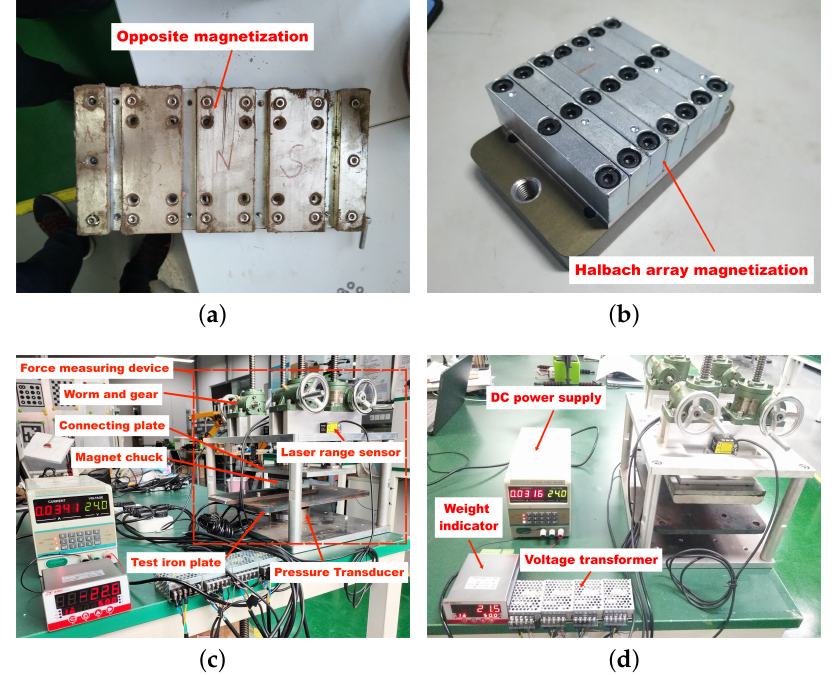
Figure 19. Practical test of the permanent magnetic chuck. ( a ) Opposite magnetization of the perma- nent magnetic chuck. ( b ) Halbach magnetization of the permanent magnetic chuck. ( c ) Tension test of the Halbach magnetized permanent magnetic chuck. ( d ) Tension test of the opposite magnetized permanent magnetic